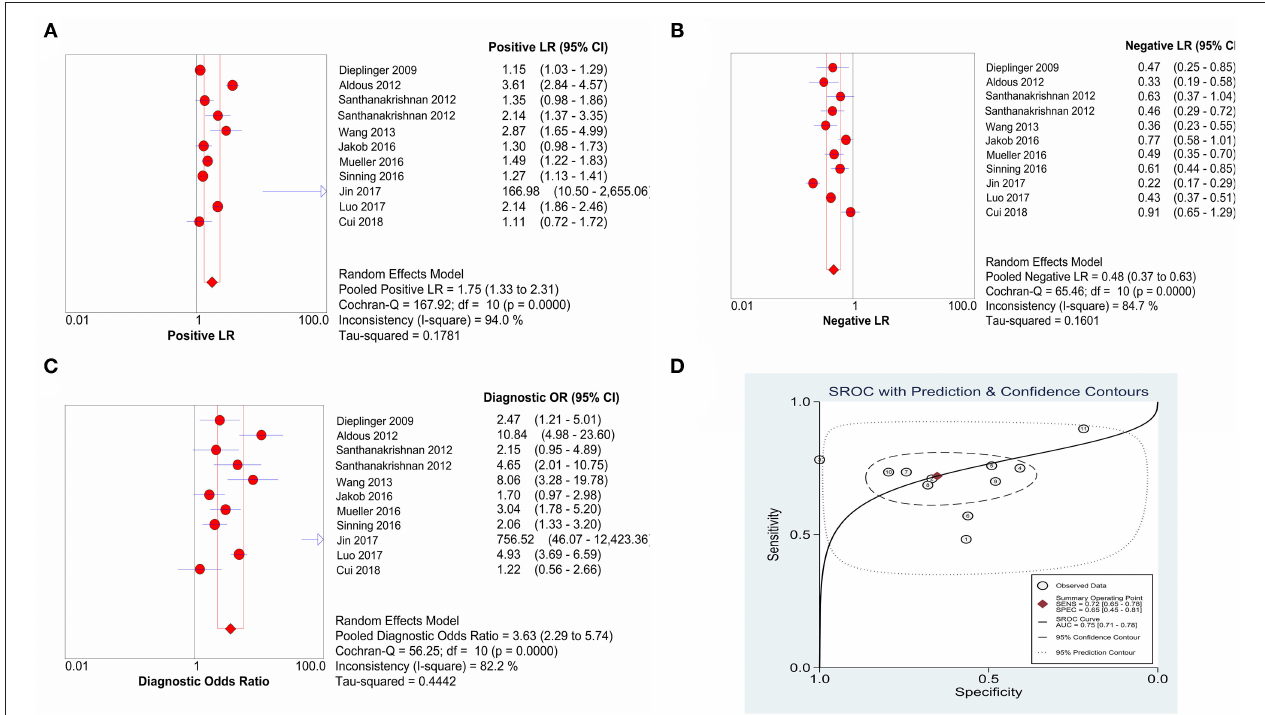
FIGURE 4 | The forest plots of (A) PLR, (B) NLR, (C) DOR, and (D) AUC of SROC. PLR, positive likelihood ratio; NLR, negative likelihood ratio; DOR, diagnostic odds ratio; AUC, area under curve; SROC, summary receiver operating characteristic.